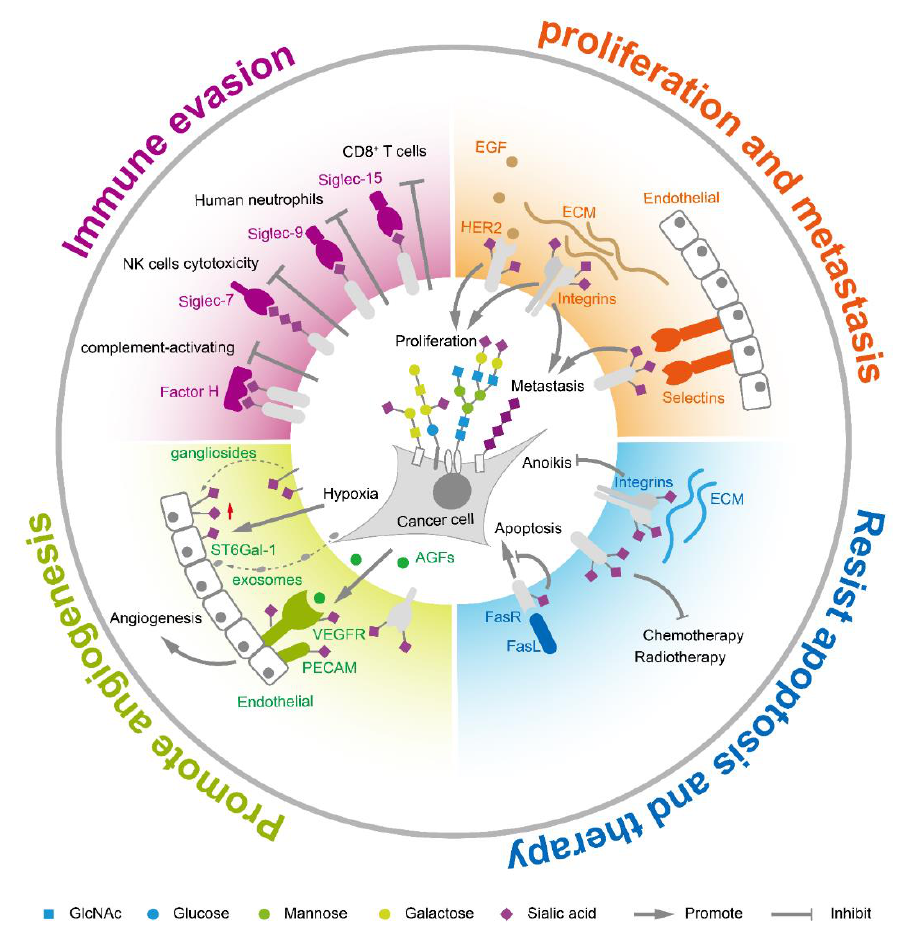
Figure 2. The functions of sialic acids in tumor biology.